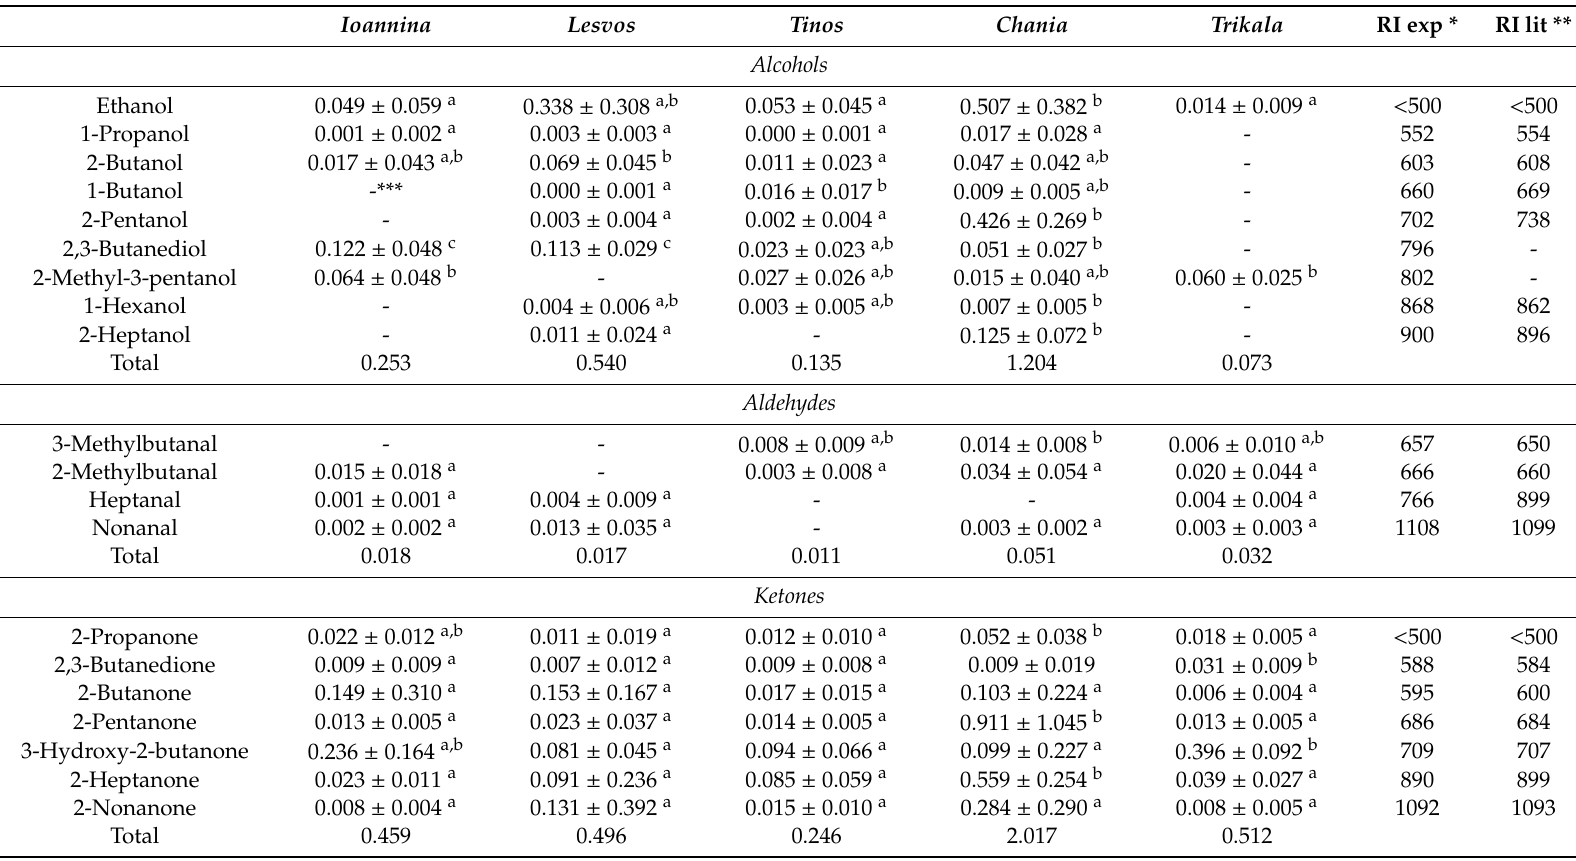
Table 3. Mean values (mg / kg) and SDs of volatile compounds (VCs) of the graviera cheese samples